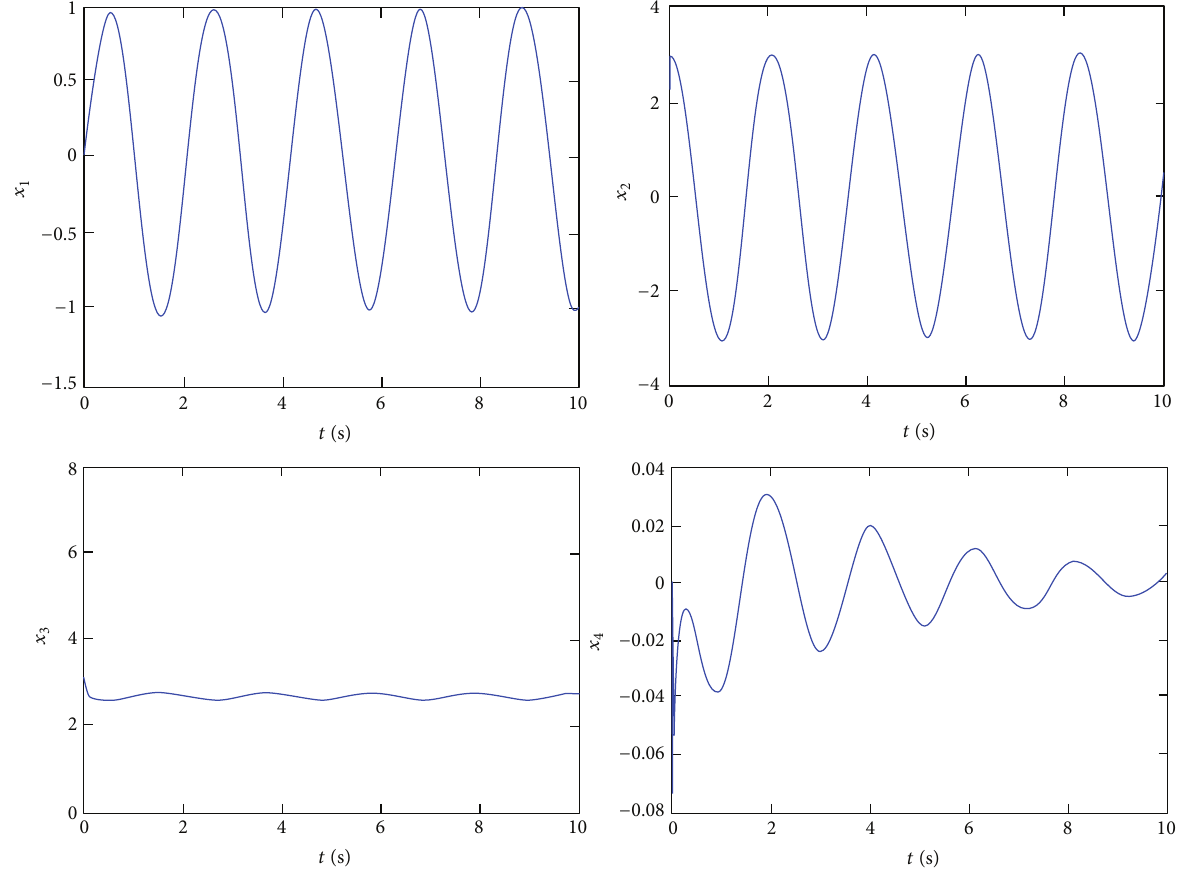
Figure 10: The curves of system state variables when utilizing the proposed